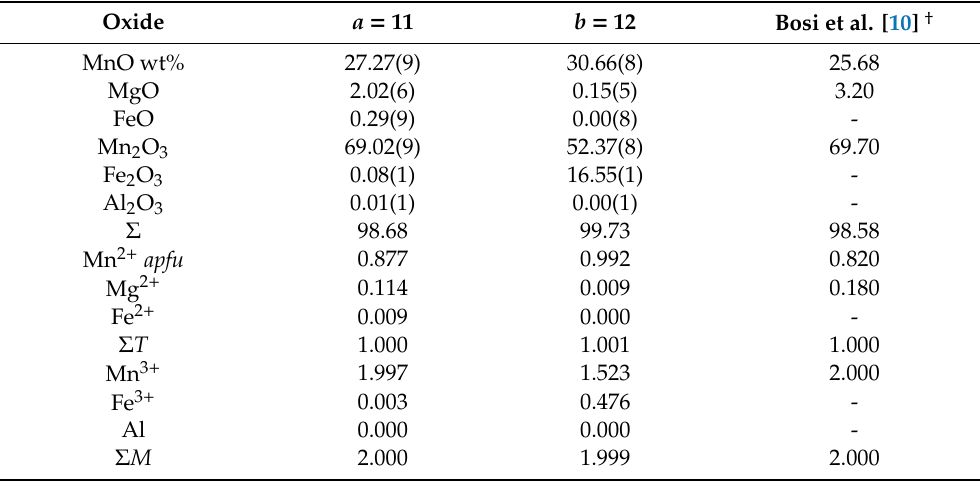
Table 2. Electron-probe microanalysis (EPMA) for hausmannite samples-a and -b compared to data from Bosi et al.